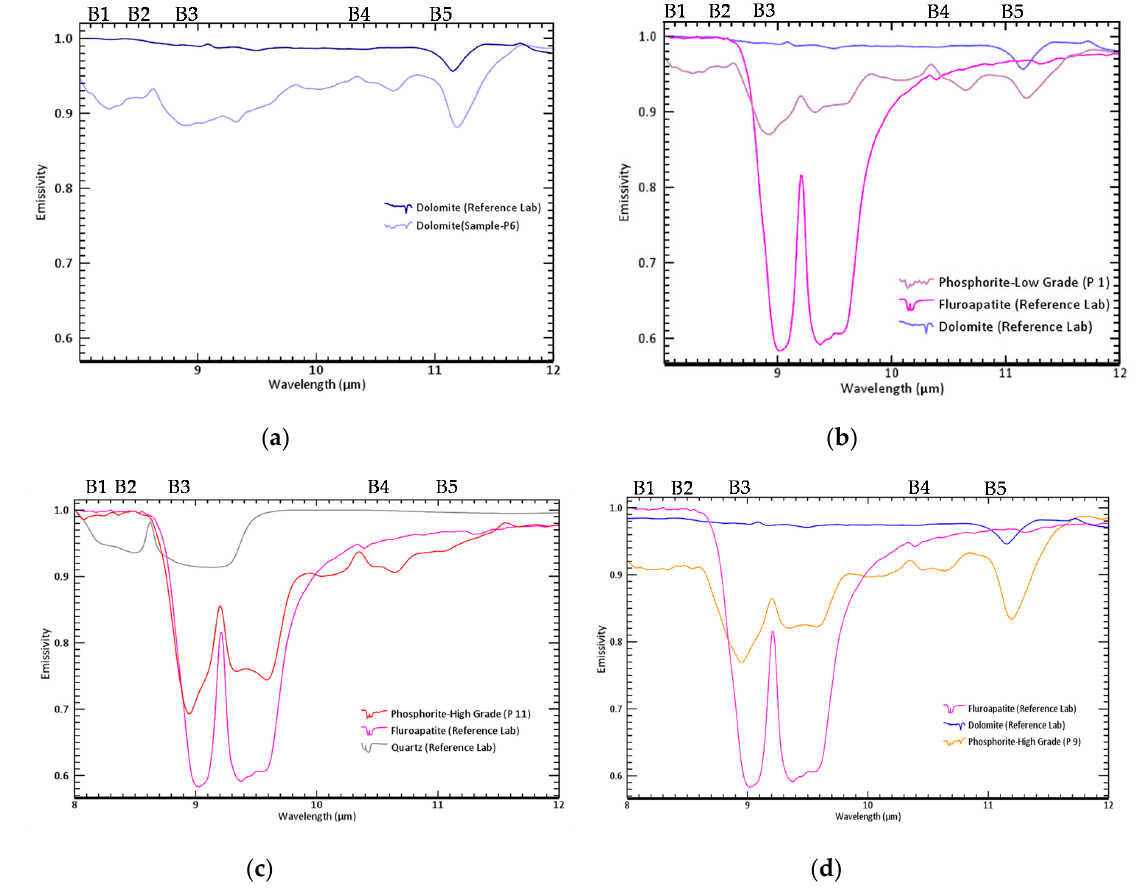
Figure 6. ( a ). Continuum removed thermal spectrum of dolomite (P6) and the spectra of the dominant constituent mineral are plotted. ( b ) Continuum removed thermal spectrum of low-grade phosphorite (P1), and the spectra of dominant constituent minerals are plotted. ( c ) Continuum removed thermal spectrum of medium to high-grade phosphorite (P11) and the spectra of dominant constituent minerals are plotted ( d ). Continuum removed thermal spectrum of medium to high-grade phosphorite (P9) and the spectra of dominant constituent minerals are plotted. Mineral spectra is collected from United States Geological Survey (USGS) spectral library. The spectral data base is available with ENVI 5.1 software package. Wavelength positions of five TIR bands of ASTER are also shown (B1 to B5).